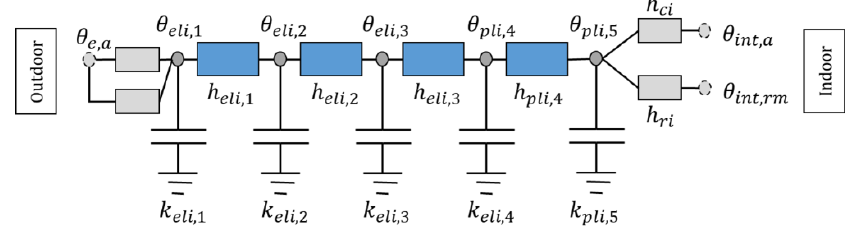
Figure 2. RC network of lumped parameters model proposed in EN ISO 52016-1.